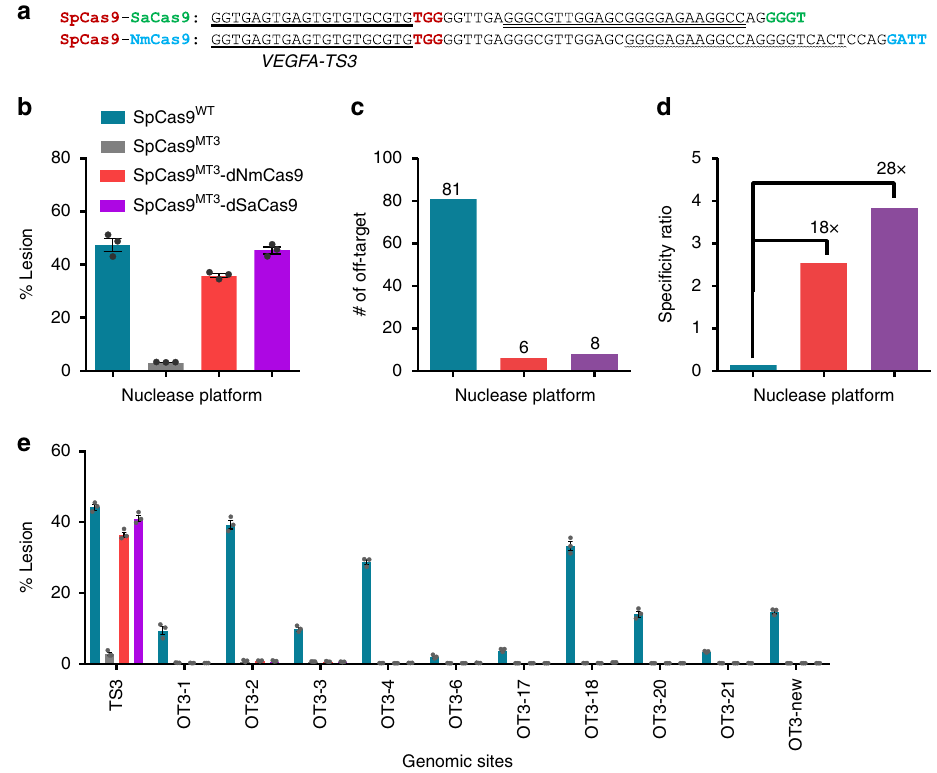
Fig. 2 SpCas9 MT – dSa/NmCas9 fusions improve the speci fi city of editing. a Sequences of dual Cas9 genomic target sites at the VEGFA locus. The SpCas9 protospacer is bold underlined with its PAM is in red, the SaCas9 protospacer is double underlined with its PAM is green, and the NmCas9 protospacer is wavy underlined with its PAM in blue. b Lesion rates of the nuclease platforms are determined by deep sequencing. c , d Genome-wide off-target analysis of the nuclease platforms determined via GUIDE-seq 12 (Supplementary Data 2). c The number of off-target peaks detected for the given nuclease. d Fold improvement of the speci fi city ratio of the Cas9 MT – dCas9 framework relative to SpCas9 WT . e Deep sequencing determined lesion rates of the nucleases at a small set of off-target sites discovered within the GUIDE-seq data. GUIDE-seq result is from a single experiment, whereas amplicon deep sequencing data are from three independent biological replicates performed on different days in HEK293T cells (Supplementary Data 1). Error bars indicate ±